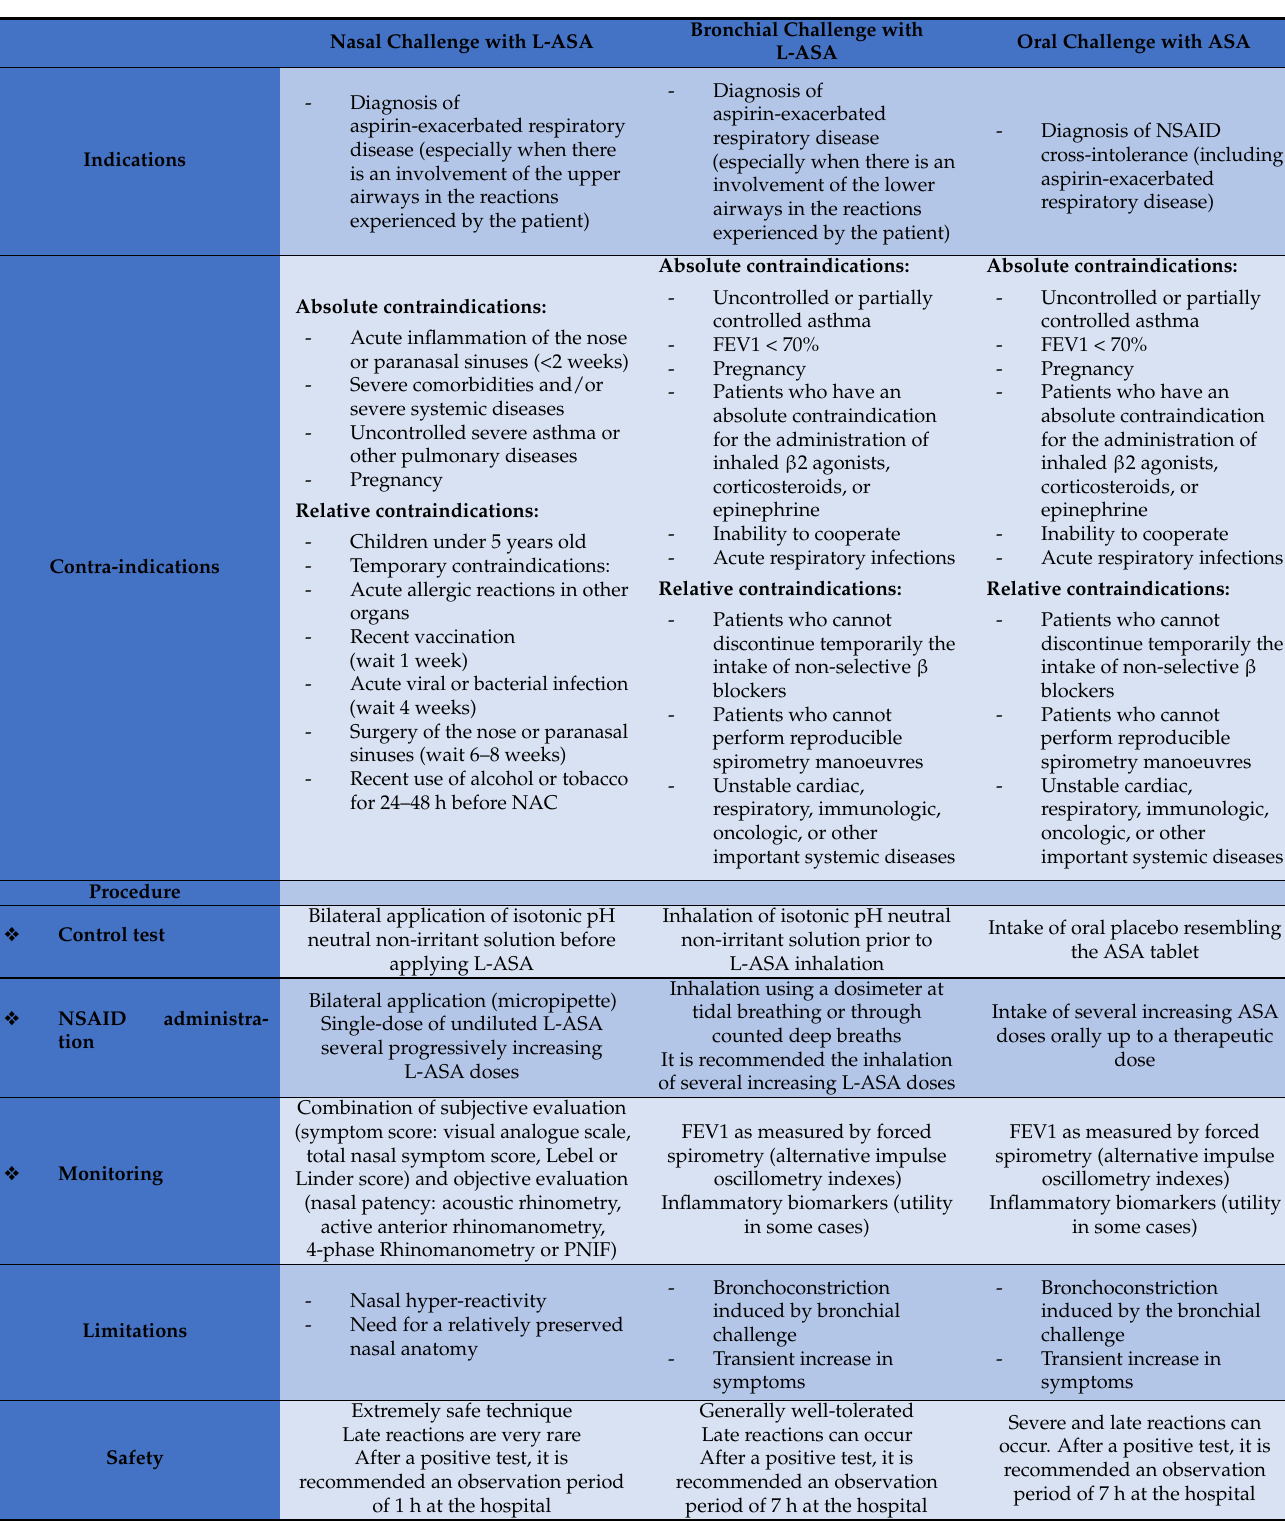
Table 2. Comparison of the oral challenge with ASA and the bronchial and nasal challenge with L-ASA. ASA: acetylsalicylic acid; FEV1: forced expiratory volume in the 1st second; L-ASA: lysine- acetylsalicylic acid; NSAID: non-steroidal anti-inflammatory drug; PNIF: peak nasal inspiratory flow. Bronchial Challenge with Nasal Challenge with L-ASA Oral Challenge with L-ASA